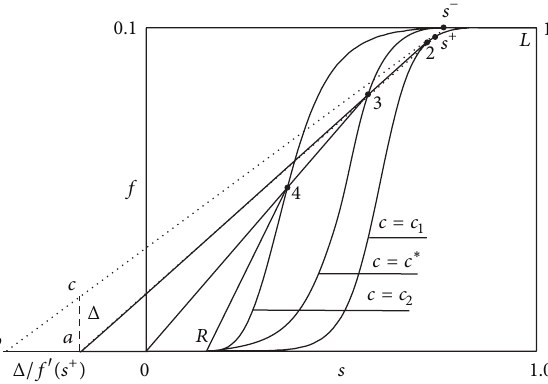
Figure 12: Solution of the lifting equation in (𝑠,𝑓) -plane.